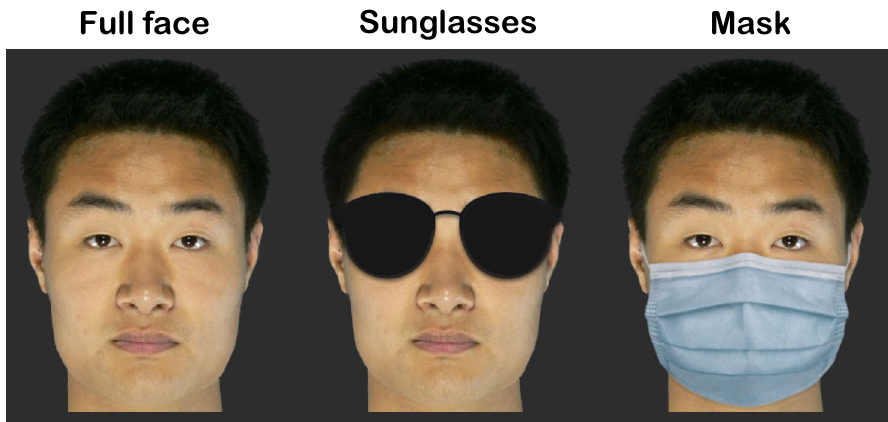
Figure 1. Example faces of the same identity in the 3 disguise types. All faces were displayed against a black screen, with clearly distinguishable head